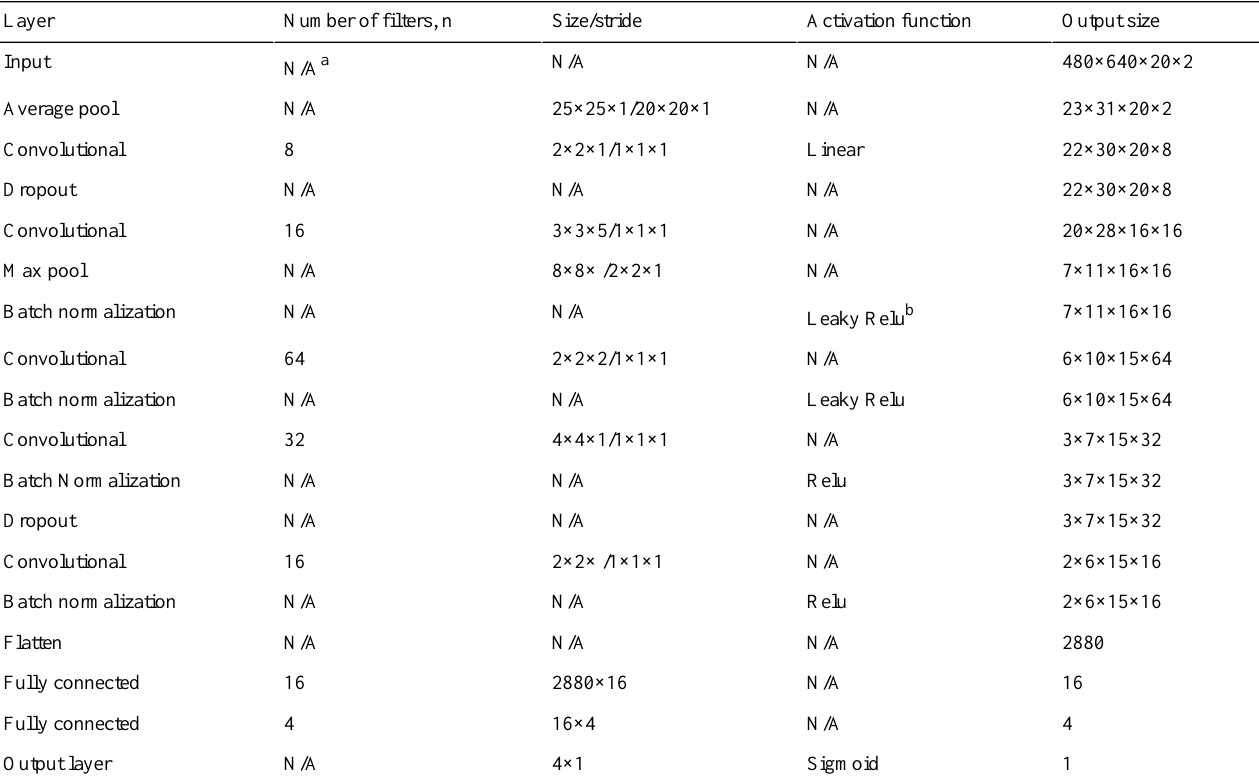
Table 1. Architecture of a 3D convolutional neural network used to distinguish obstructive apnea from central apnea.